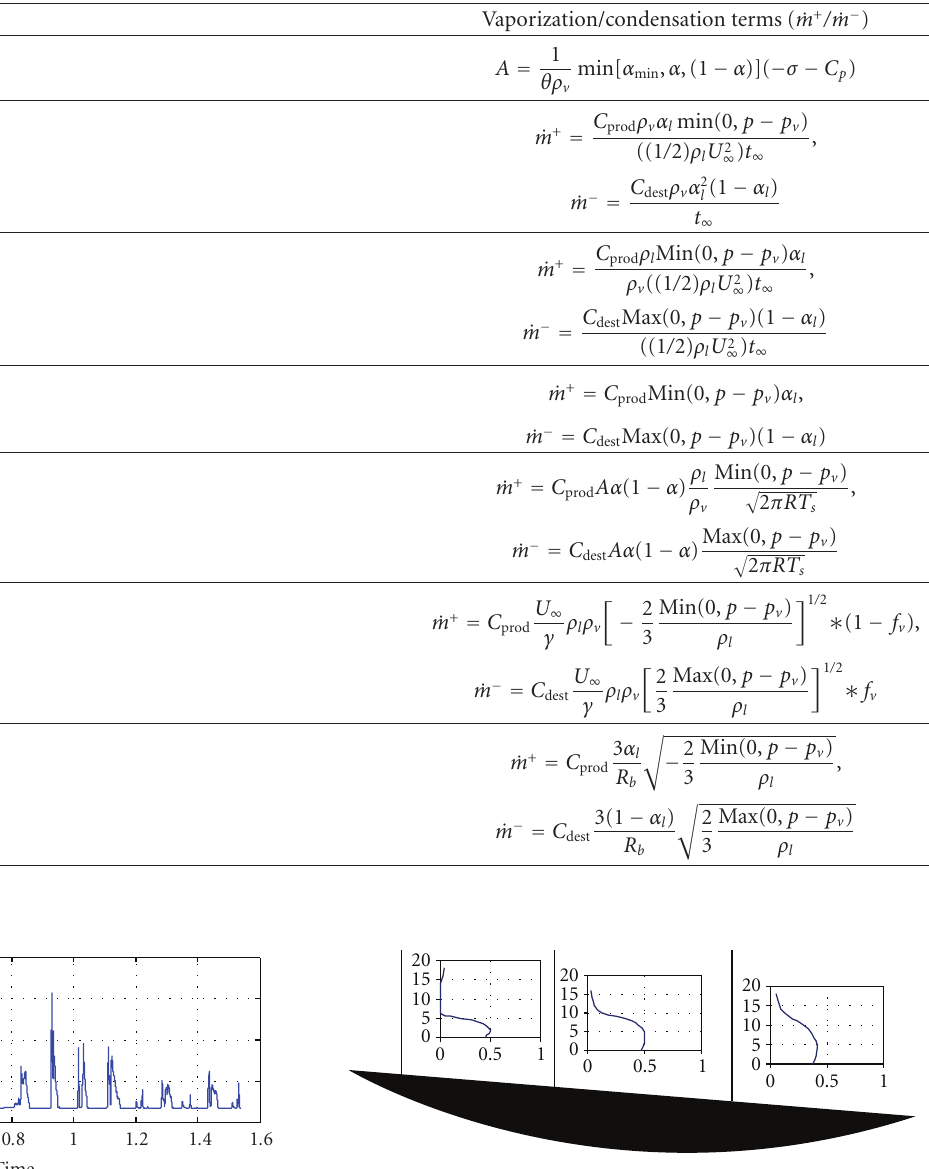
Figure 8: Position of the experimental void fraction measurements ( V ref = 6 m/s, L/c =